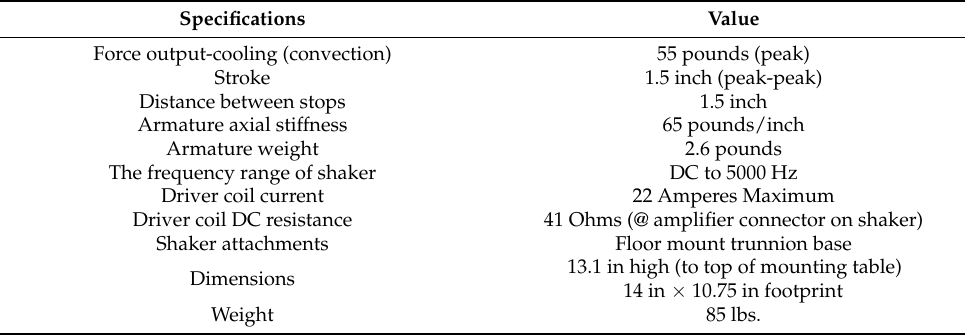
Figure 1. Drawing of the plate in SolidWorks Software. Table 1. Specification of the energizer red shaker shown in Figure 2.